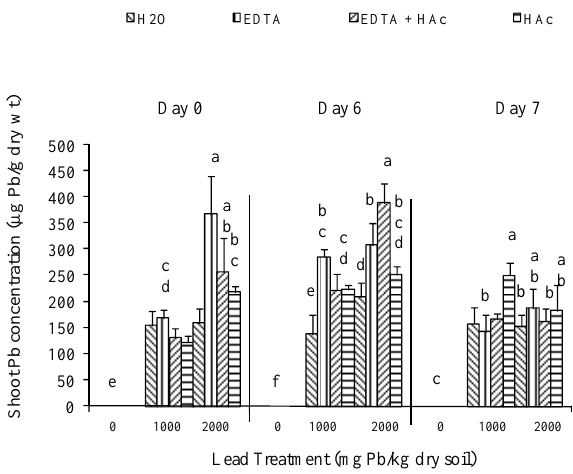
Figure 3: Effects of lead and chelates on shoot Pb concentrations (µg Pb/g dry wt.) of Sesbania exaltata Raf. at different days (0,6, 7) after chelate application. Chelates were applied at 6 weeks after seedling emergence. Values and error bars represent means and standard errors of 4 replicates. Treatments with common letters do not differ significantly from other treatments within the same time period (Fisher's LSD p < 0.05).